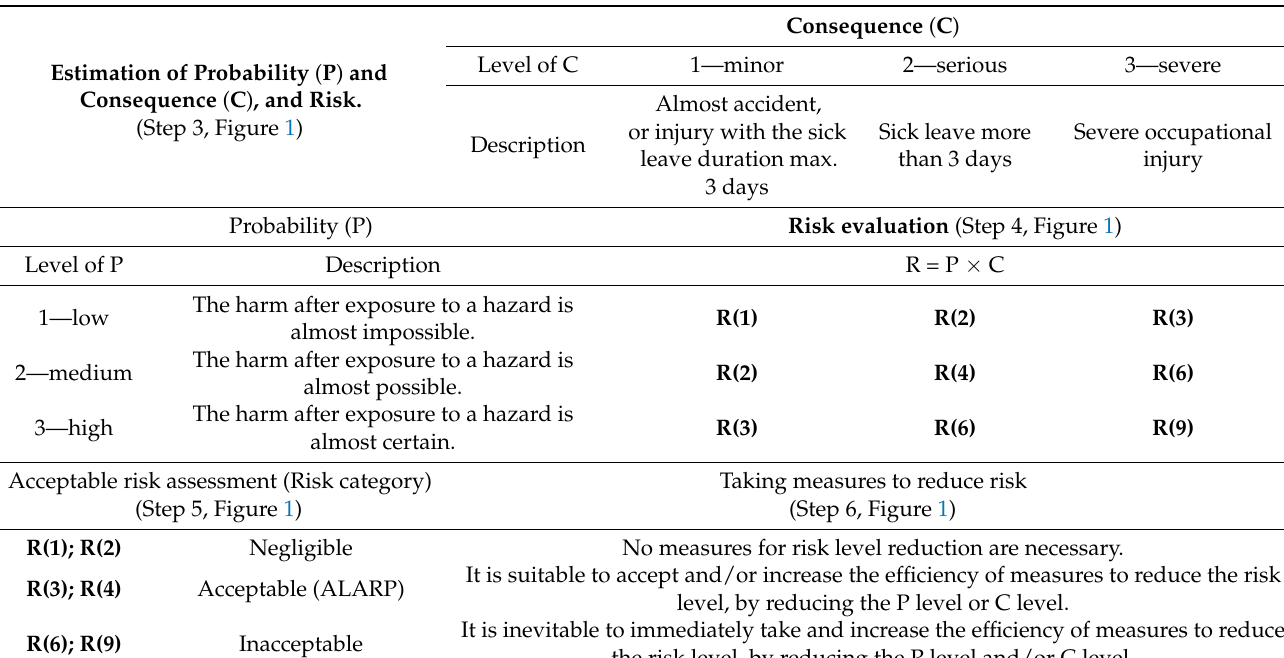
Table 1. Example of a constructed “risk matrix” according to the algorithm for risk assessment (source: own design).